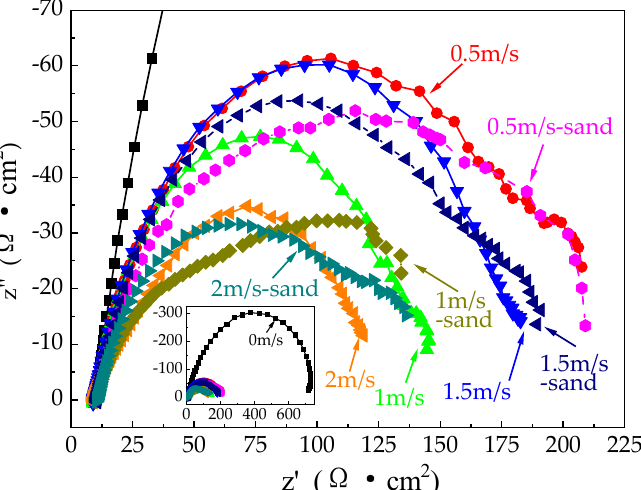
Figure 3. EIS diagram measured on 20 # steel in the oilfield brine with/without sand under different flow velocities.